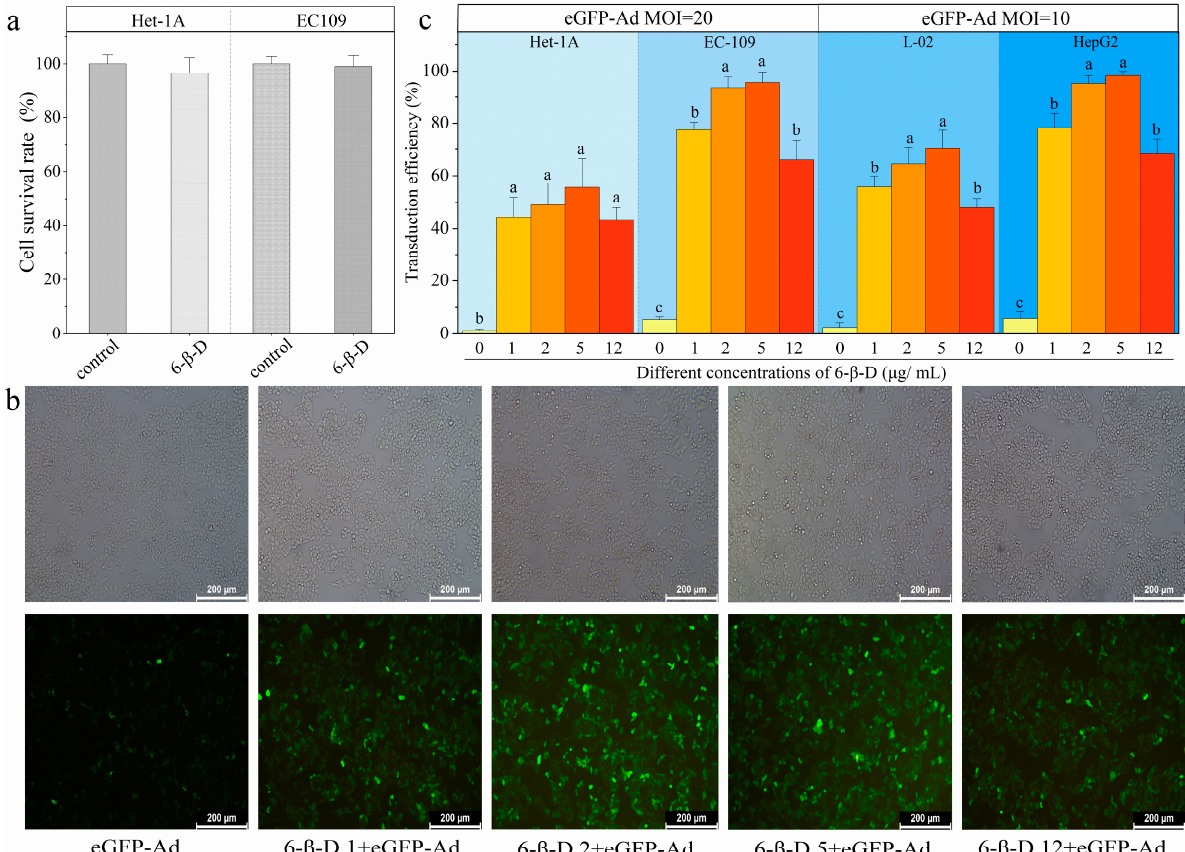
Figure 2. When eGFP was used as a reporter gene, 6- β -D showed low cytotoxicity and high trans- duction efficiency in different human cell lines. ( a ) Cytotoxicity of 6- β -D on Het-1A and EC109 cells; ( b ) 6- β -D promoted eGFP expression in EC109 cells; ( c ) Transduction efficiency of eGFP-Ad was affected by different concentrations of 6- β -D. Note: The same letter means no significant difference ( p > 0.05), while different letters indicate that differences reached significant levels ( p < 0.05).